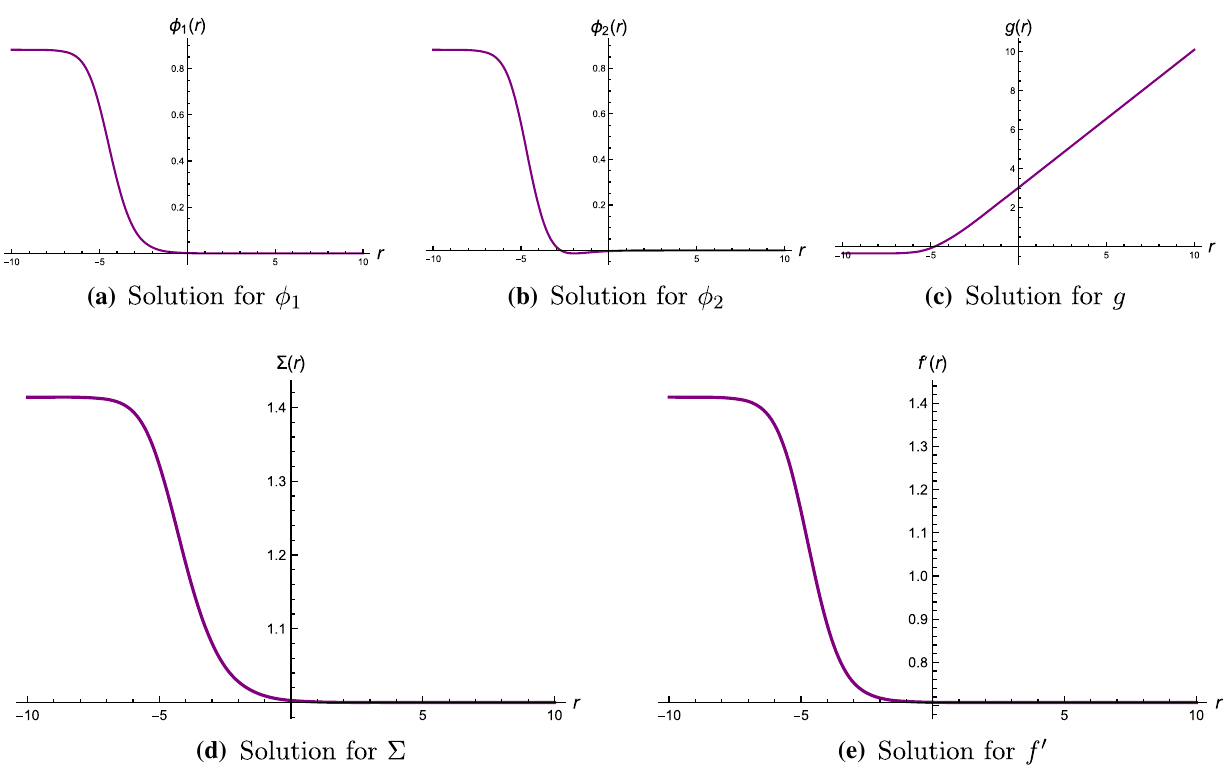
Fig. 3 An RG flow from AdS 5 critical point with U ( 1 ) × SU ( 2 ) × SU ( 2 ) symmetry to AdS 3 × H 2 critical point II for g 1 = 1 and g 3 = 2 g 1